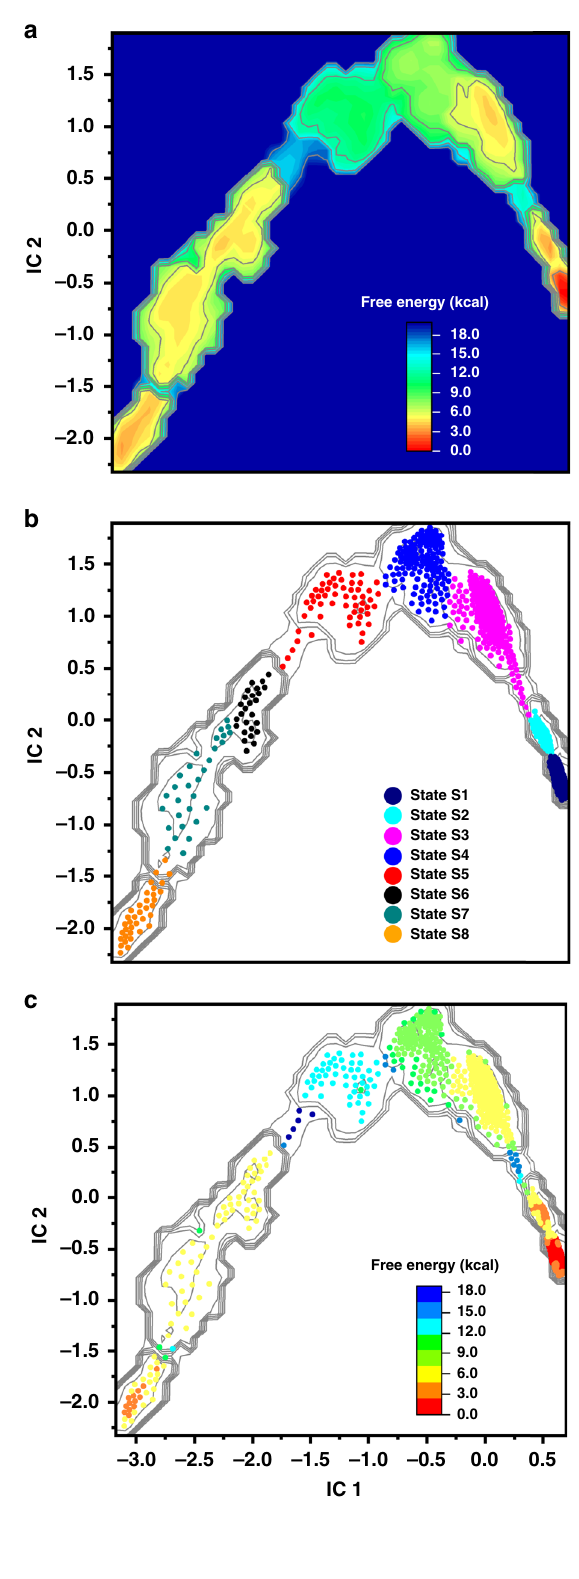
path. Since unbiased MD yields an ensemble obeying Boltzmann statistics, it becomes possible to analyze this ensemble and identify metastable states, corresponding to stable intermediates along the path. Moreover, the MD trajectories hold information on all observed state-to-state transitions, which allows us to construct kinetic models linking the on-path metastable states.